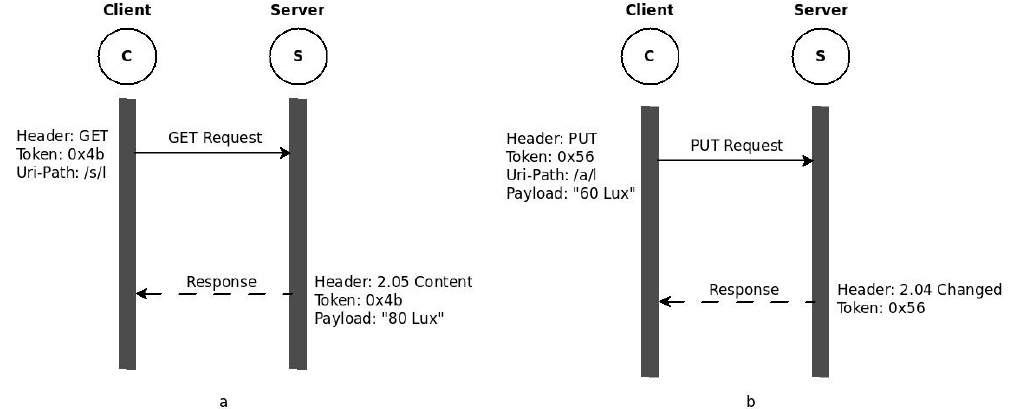
Figure 1. ( a ) CoAP GET Operation; ( b ) CoAP PUT Operation.